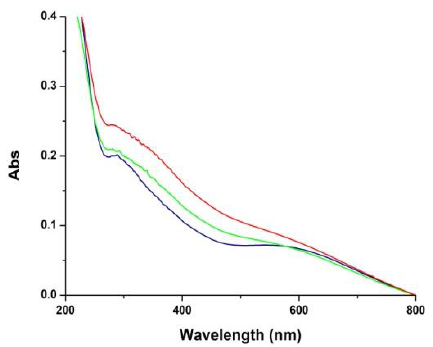
Figure 8. Ultraviolet–visible (UV–visible) spectra of polydopamine (PDA) coating (blue trace), and PDA coating immersed in a 0.1 mM dopamine solution at pH 9.0 for 3 (green trace) and 6 h (red trace).